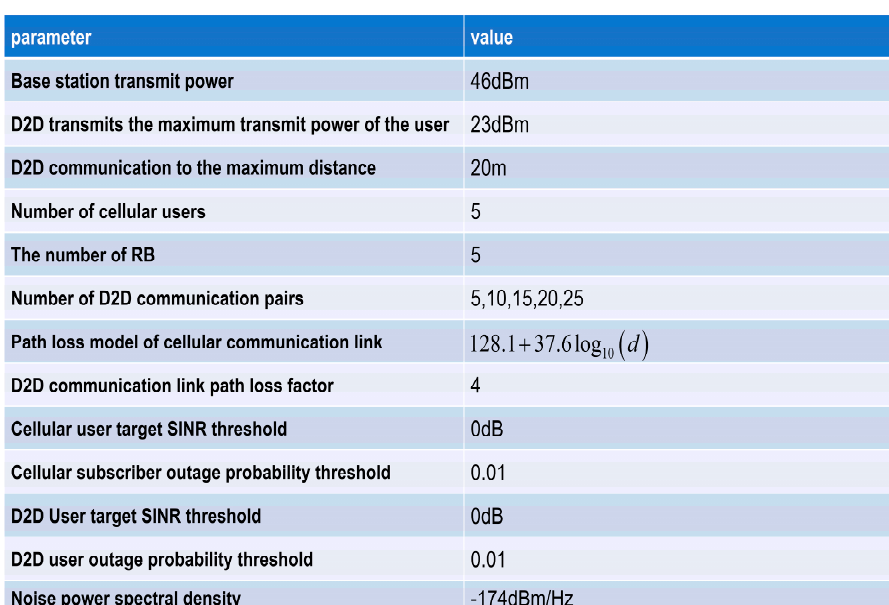
11 of 17 Table 1. Simulation Parameters. Simulation parameters Parameter value(unit) Base station transmit power 46 dBm D2D transmits the maximum transmit power of the user 23 dBm D2D communication to the maximum